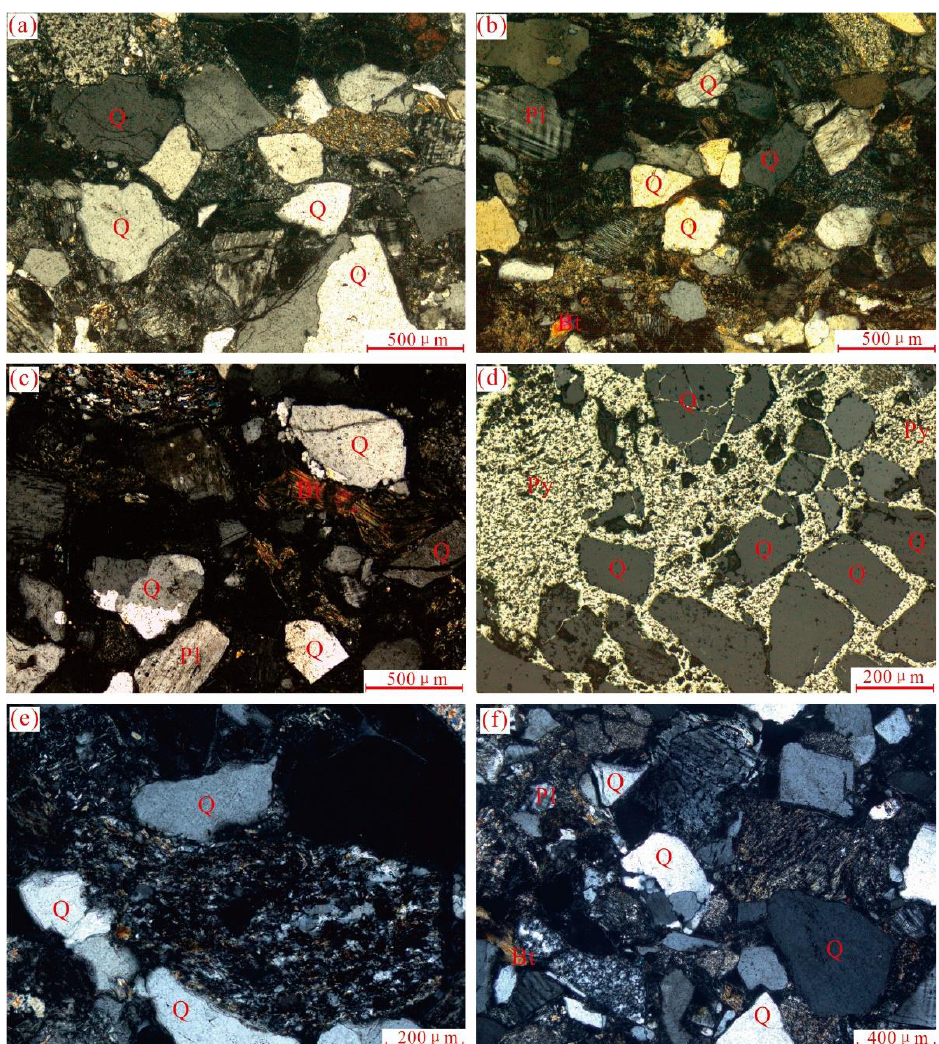
Figure 3. Photomicrograph of the Zhiluo Formation sandstones. ( a ) Quartz particles with secondary enlargement edge, complex clastic composition, pore-contact cementation; ( b ) mica flakes are strongly curved; ( c ) hydromicazation of some plagioclases and deformation structure of biotite; ( d ) pyrite cementation debris containing disseminated fine-grained pyrite; ( e ) Metamorphic rock debris can be clearly seen, and some quartz particles have secondary enlarged edges; ( f ) contact cementation. All photomicrographs were taken using cross-polarized light; Q, quartz; Pl, plagioclase; Py, pyrite; Bi,